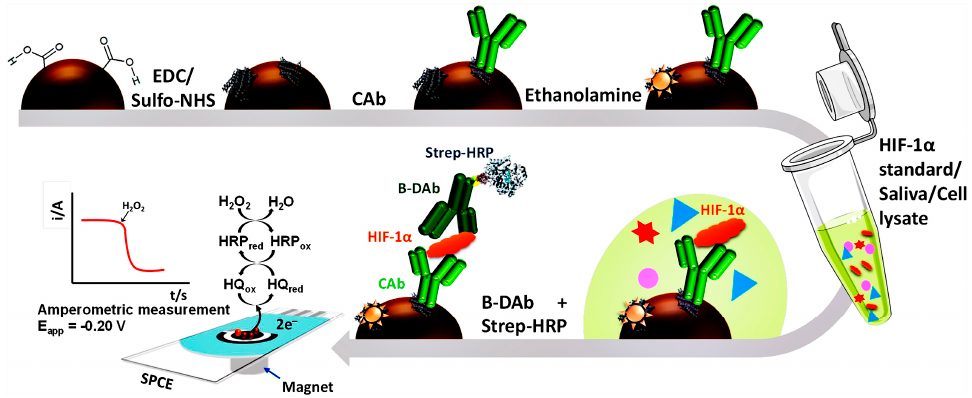
Figure 5. Schematic display and reactions involved in the MB–based immunoassay for the determi- nation of HIF–1 α [80]. Copyright (2020) Elsevier.